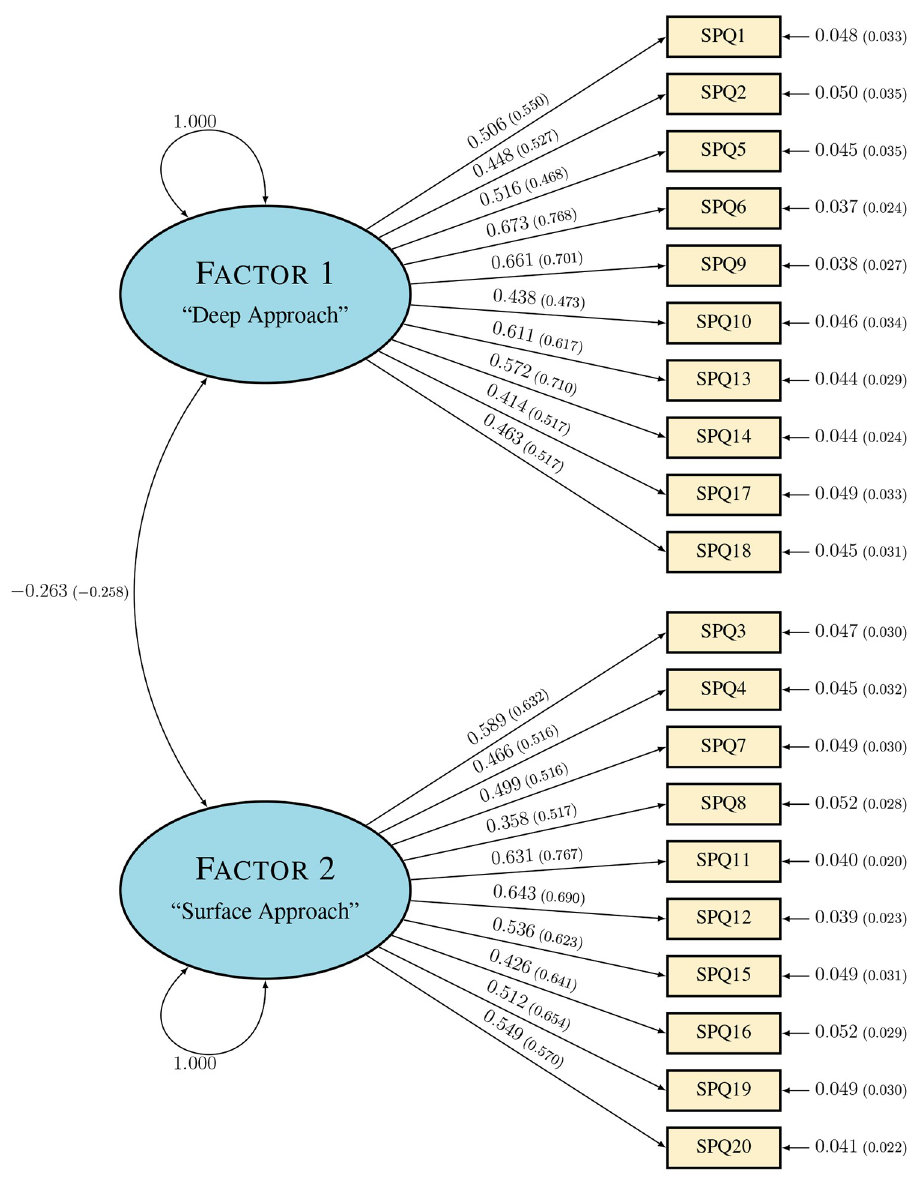
Fig 3. The hypothesized two-factor structure of the Revised Study Process